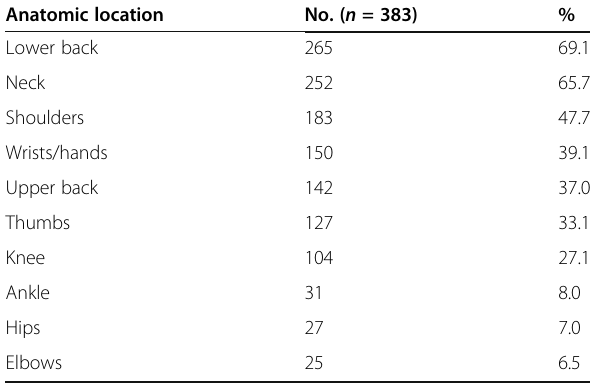
Table 2 Distribution of WMSDs as reported by participants Anatomic location